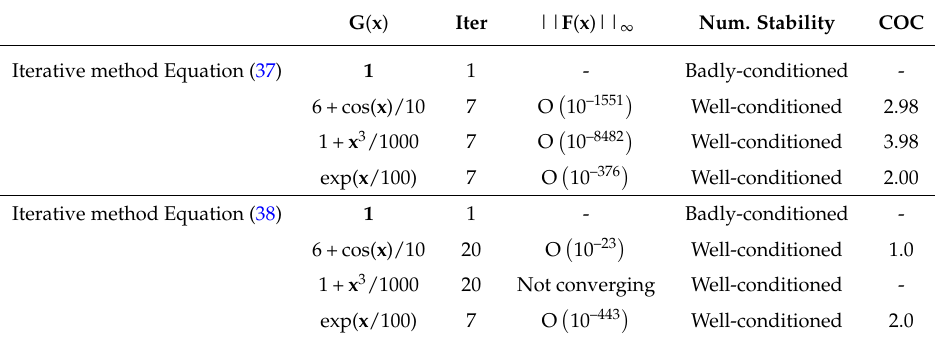
Table 2. Problem 2: initial guess = [1,2,4,3], m =